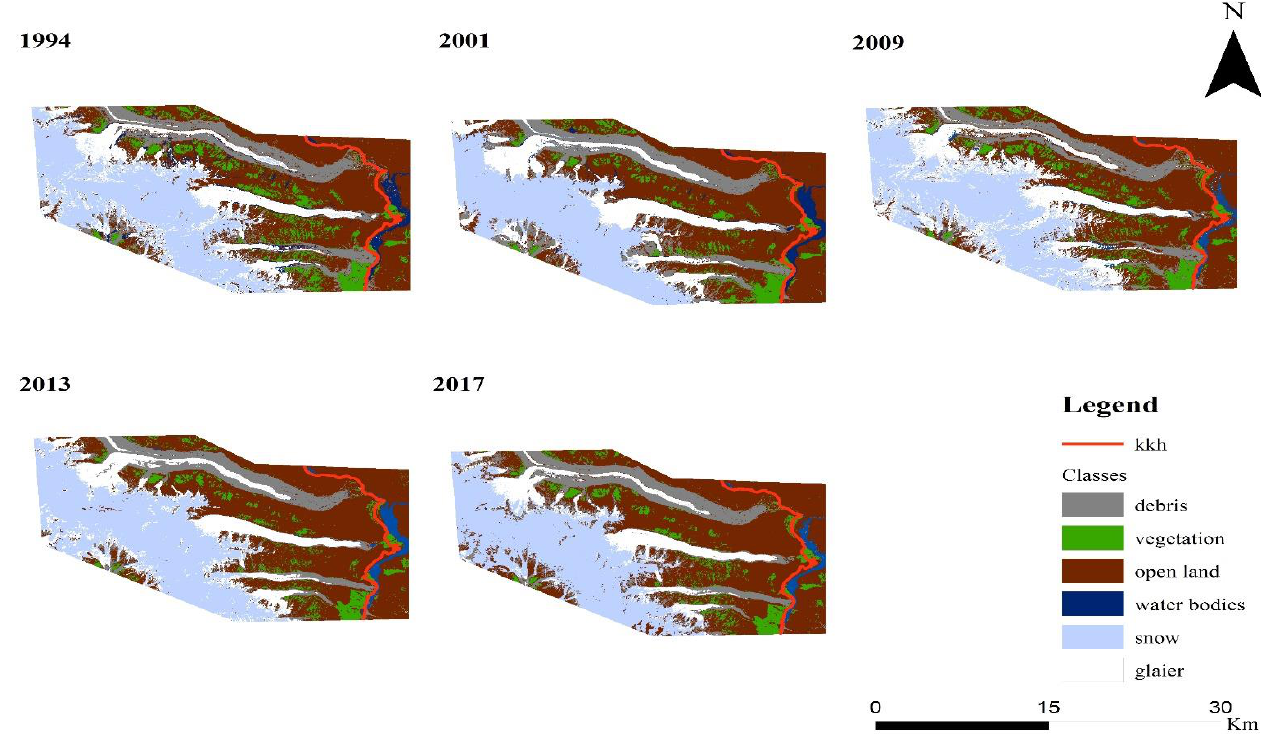
Figure 3: Spatiotemporal change of Glacier (1994-2017)